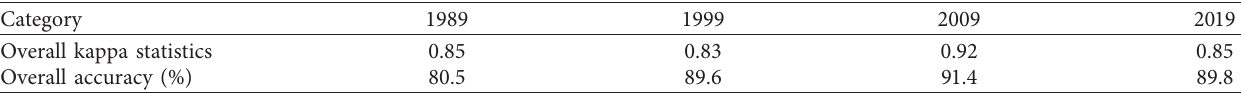
Figure 6: LANDSAT imagery classified land use maps of the basin for 1989, 1999, 2009, and 2019 (a, b, c, and d, respectively). Table 7: Overall kappa statistics and accuracy for 1989, 1999, 2009, and 2019 LULC